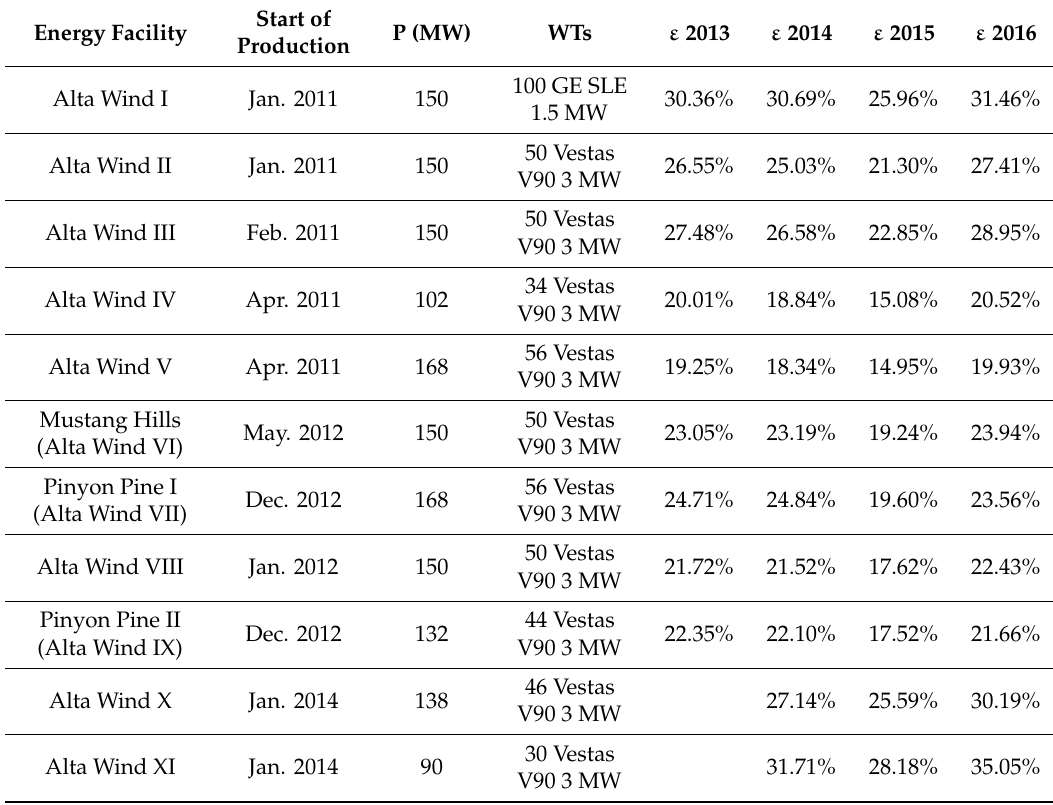
Table 3. Alta Wind Energy Center